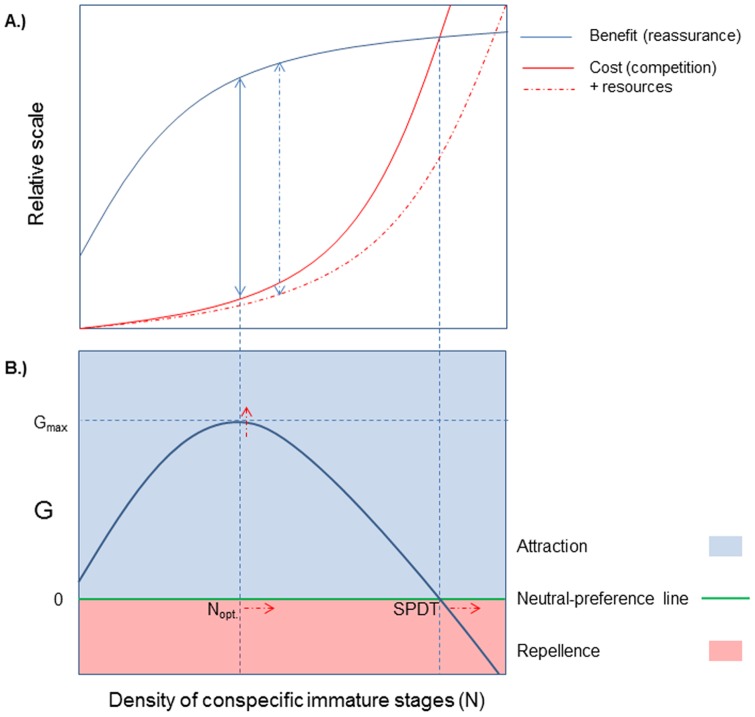
The Hump-Shaped Regulation (HSR) model.(A) Cost-benefit model of the relationship between conspecific immature stage density and the reassurance benefit due to egg or larvae aggregation and cost of competition in the absence and presence of resources. Two-headed smoothed and dashed arrows represent the maximal net benefit in the absence and presence of resources, respectively. (B) The trade-off between the benefit of reassurance and the cost of intra-specific competition should result in a hump-shaped relationship between conspecific immature density and fitness (G). Gmax indicates the maximal fitness and Nopt indicates the density at which it occurs. The switching preference density threshold (SPDT) indicates the conspecific density at which this fitness line crosses the neutral-preference line. This neutral-preference line dissects the state-space into regions of conspecific attraction (G > 0, light blue) and repellence (G < 0, pink). Hence, at densities below the SPDT attraction to conspecific immature stages should be exhibited while above it repellence from conspecific immature stages should be exhibited. Red dashed arrows indicate the expected shift in Nopt, Gmax, and SPDT due to resource addition.